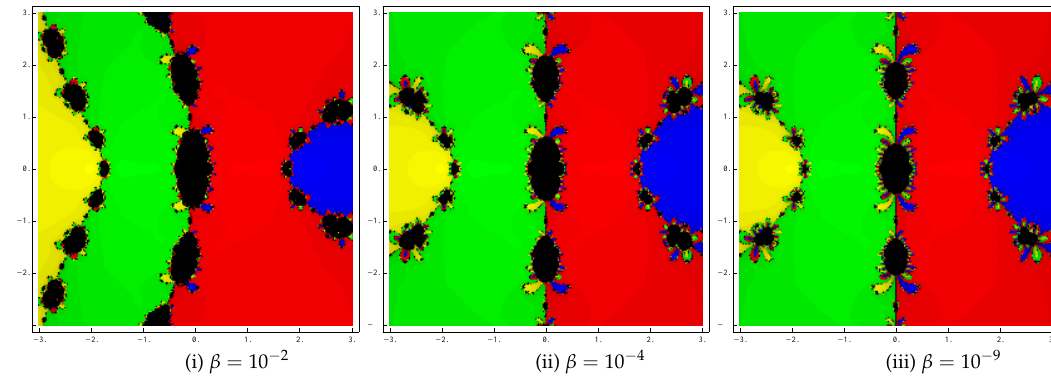
Figure 1. Basins of attraction of method for polynomial p 1 ( z ) .